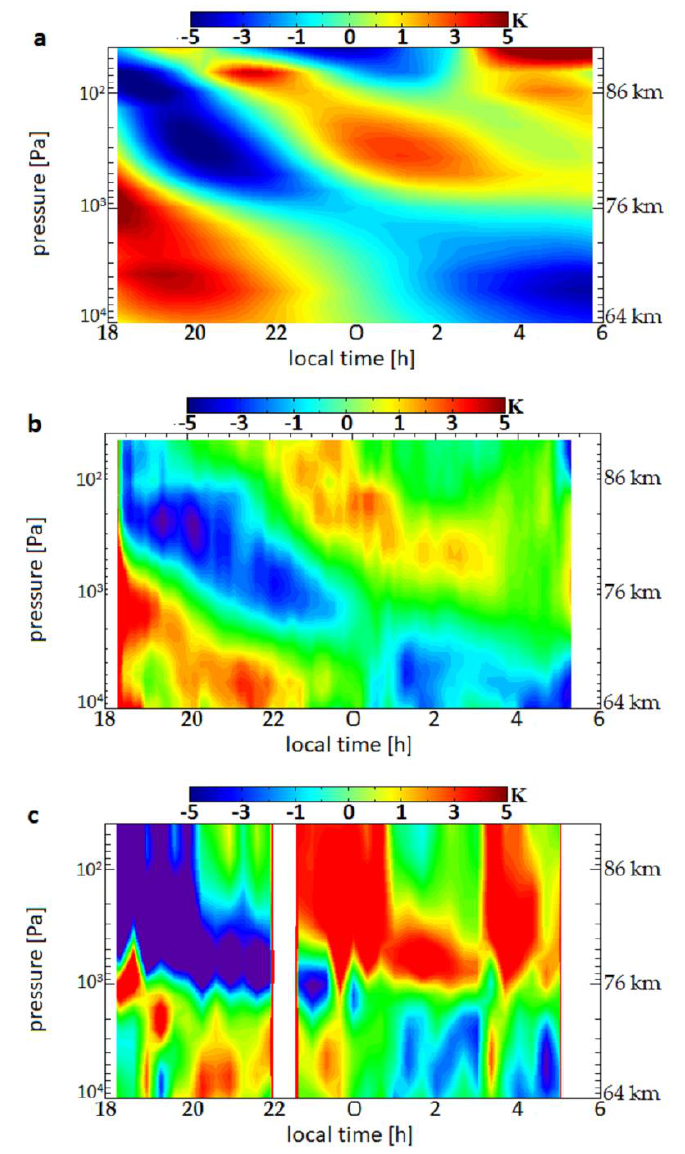
Figure 7. Altitude-local time distribution of the temperature residuals anomalies (K) at − 45 ◦ . ( a ) GCM Figure 7. Altitude- local time distribution of the temperature residuals anomalies (K) at −45°. ( a ) GCM simulations; ( b ) VIRTIS-M observations; ( c ) VIRTIS-H simulations; ( b ) VIRTIS-M observations; ( c ): VIRTIS-H observations.